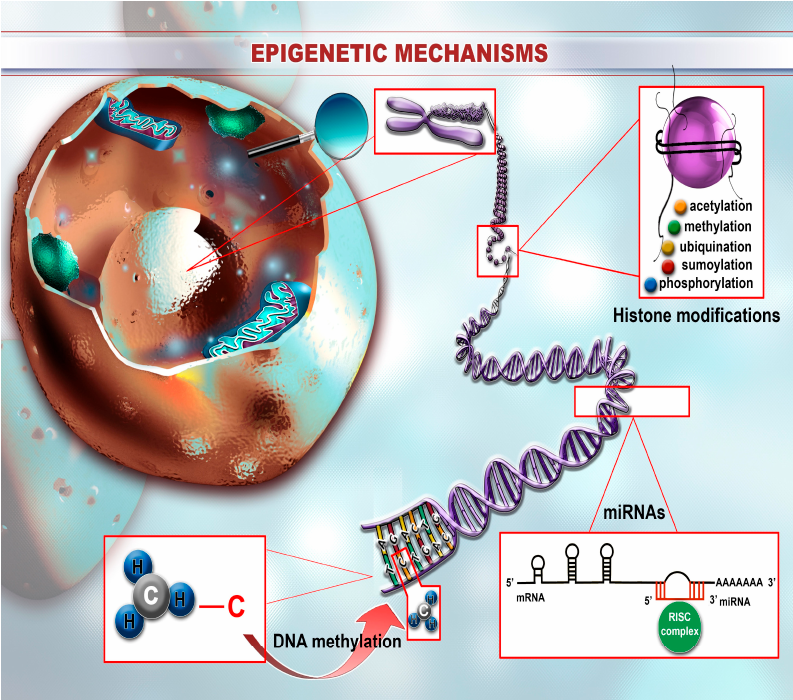
Figure 1. The landscape of epigenetic mechanisms. Epigenetic changes consist of reversible modifica- tions affecting the structure of the DNA/chromosome that are further translated at the protein level through expressional changes. One of the most studied epigenetic mechanisms consists of DNA meth- ylation that occurs mainly within the CpG islands that are located in different repetitive genome